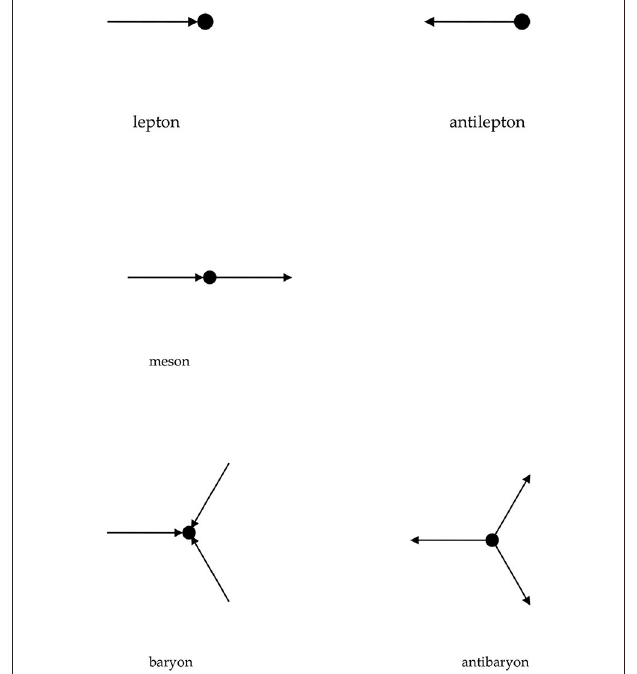
FIGURE 2 | Directed glyphs. Only internal edges (elementary fermions) are here